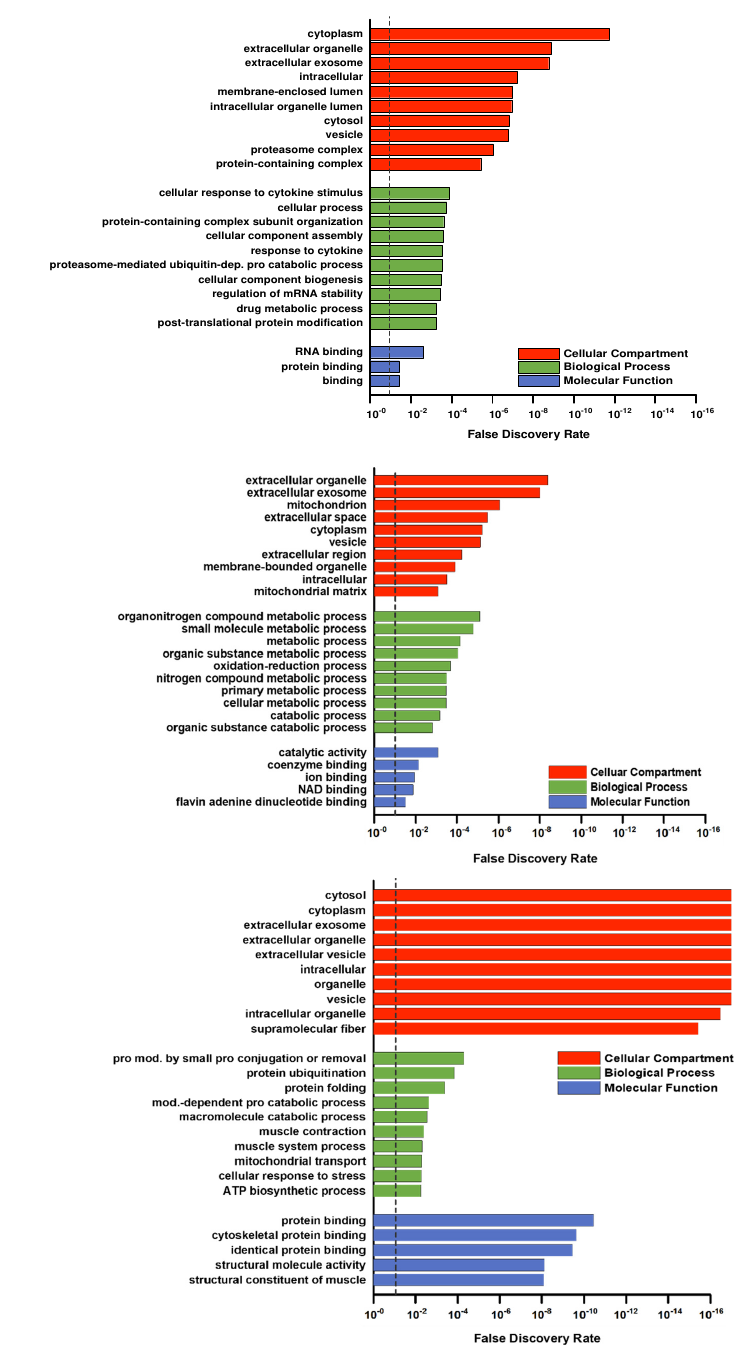
Figure 3. Gene Ontology (GO) analysis of proteins from the ( a ) intersection, ( b ) collagen group, and ( c ) placebo group after 12 weeks of resistance training and supplementation calculated by PANTHER. The false discovery rate (FDR) is marked with a dashed line at 0.10.